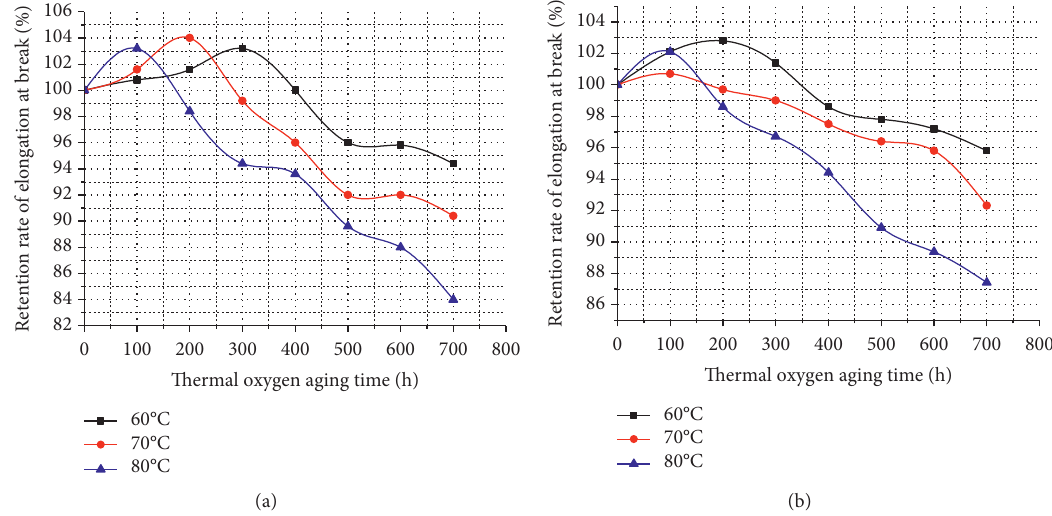
Figure 5: Relationship curves of elongation at break-thermal aging time. (a) BG1. (b)